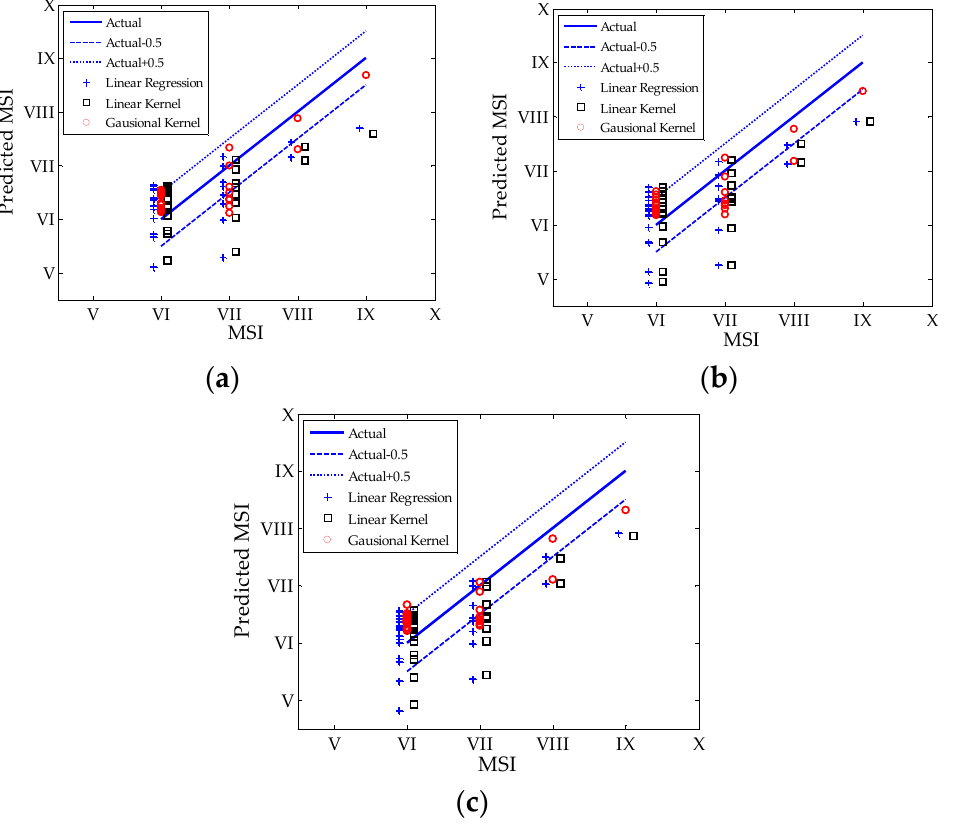
Figure 8. Performance comparison of regression models with Gaussian kernel and linear kernel SVRs and linear regression. ( a ) One feature; ( b ) two features; ( c ) seven features.